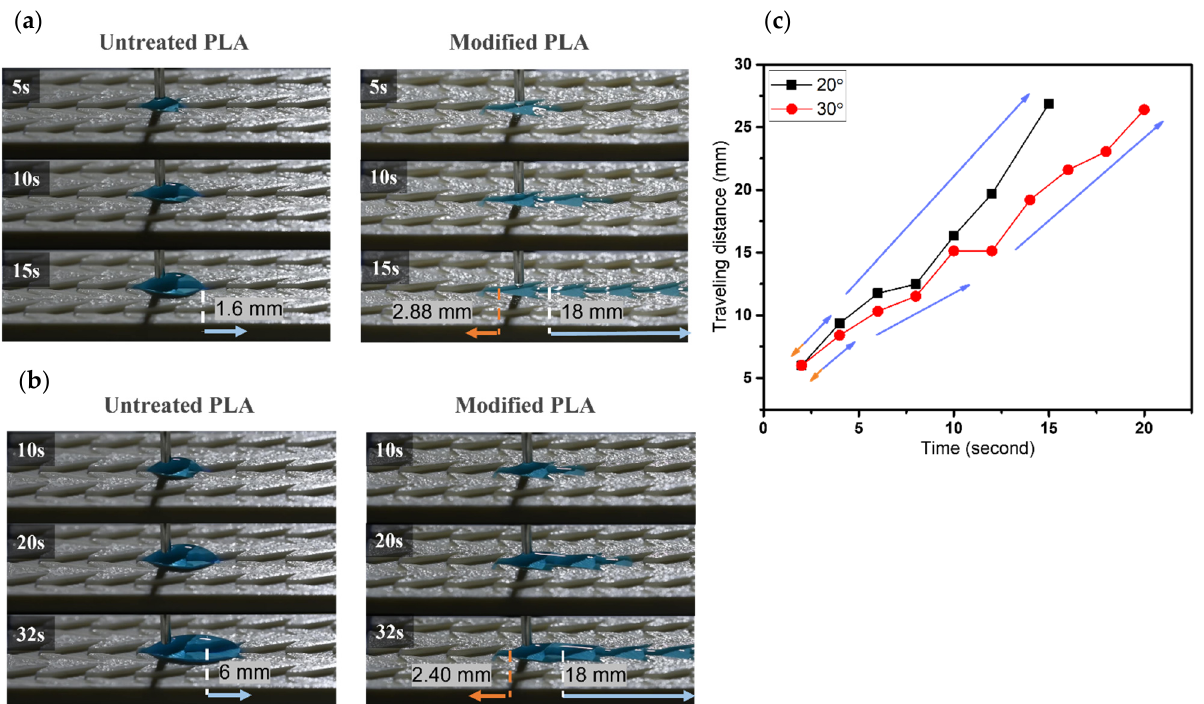
Figure 11. The dynamic wetting behavior of water droplets in the 3D-printed dart-shaped pattern with β angle of ( a ) 20 ° ; ( b ) 30 ° ; and ( c ) Plot of traveling distance versus time with the directions of droplet movement wetting of modified pattern. The orange arrow denotes the opposite side, and the blue one denotes the predominant side.